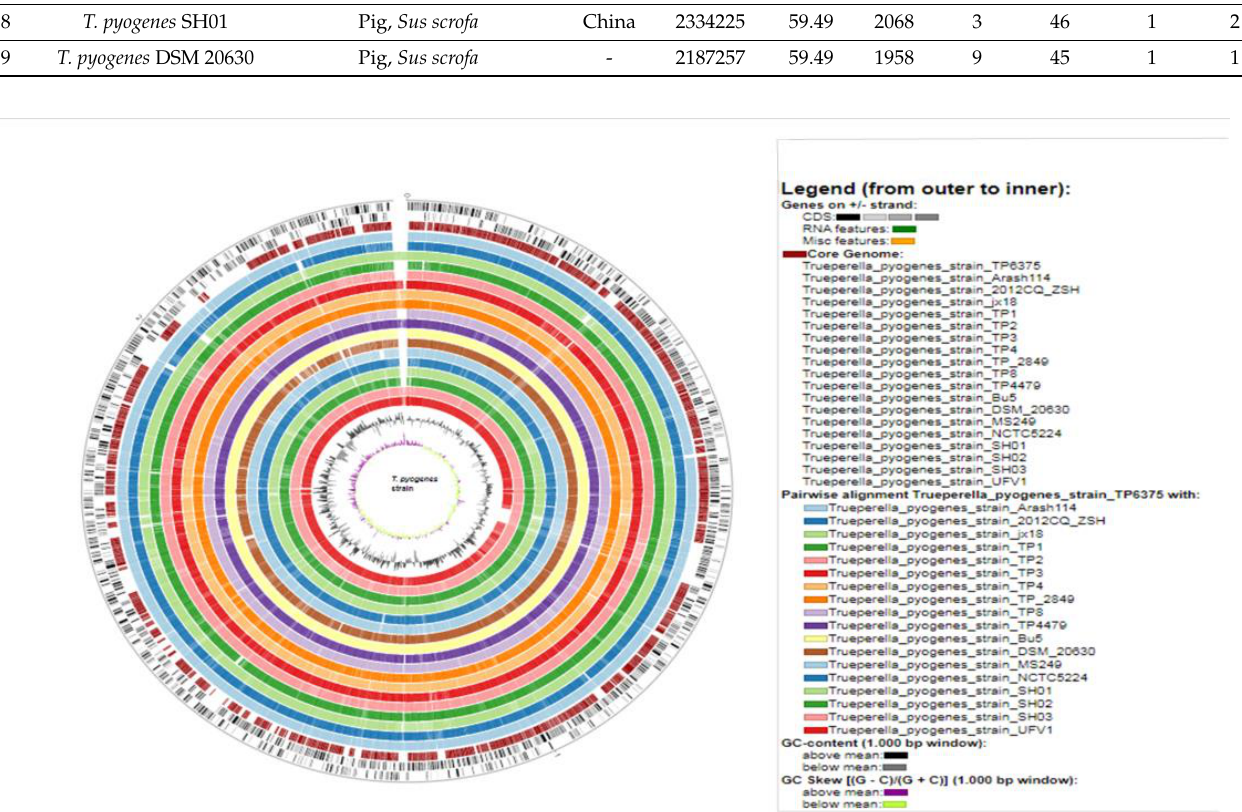
Figure 2. Circular representation of nineteen T. pyogenes genomes with reference genome as T. pyogenes TP6375.From outside to inside, the figure depicts CDS, core-genome, pairwise align- ment of investigated T. pyogenes strains against reference genome T. pyogenes TP6375, GC content, and GC skew in different